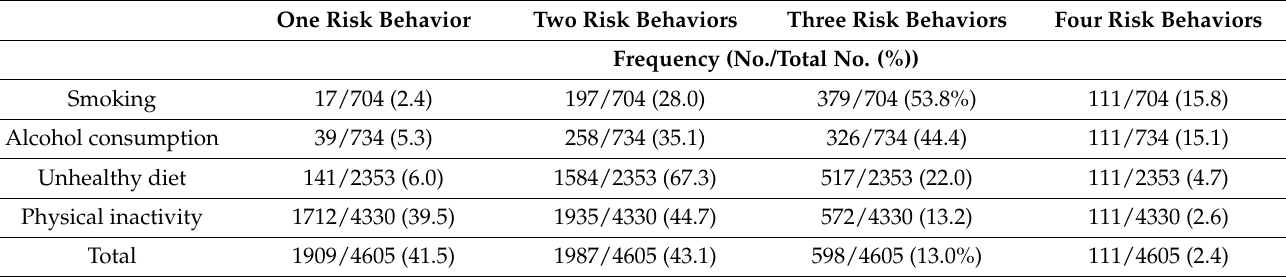
Table 4. The clustering of four health-risk behaviors ( N =